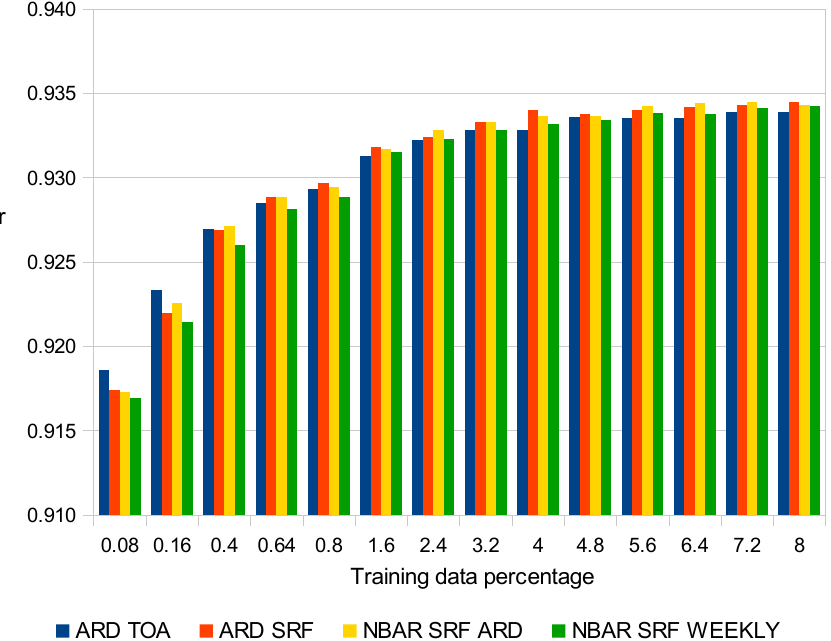
Figure 2. Pearson’s correlation coefficient accuracy results derived as (1) for the four data processing levels using top of atmosphere ARD (TOA ARD), atmospherically corrected ARD (SRF ARD), BRDF adjusted atmospherically corrected ARD (NBAR SRF ARD), and weekly composited BRDF adjusted atmospherically corrected ARD (NBAR SRF WEEKLY). The results considering an increasing percentage of the training data are shown.